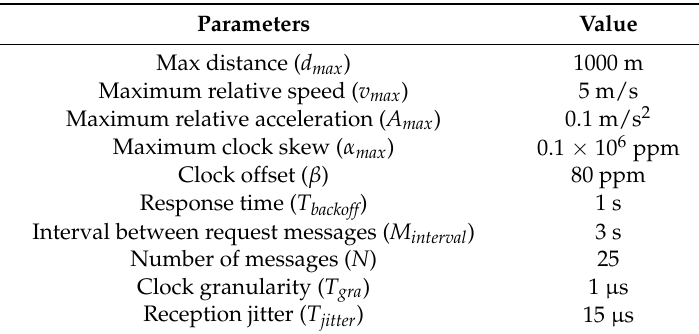
Table 2. Simulation